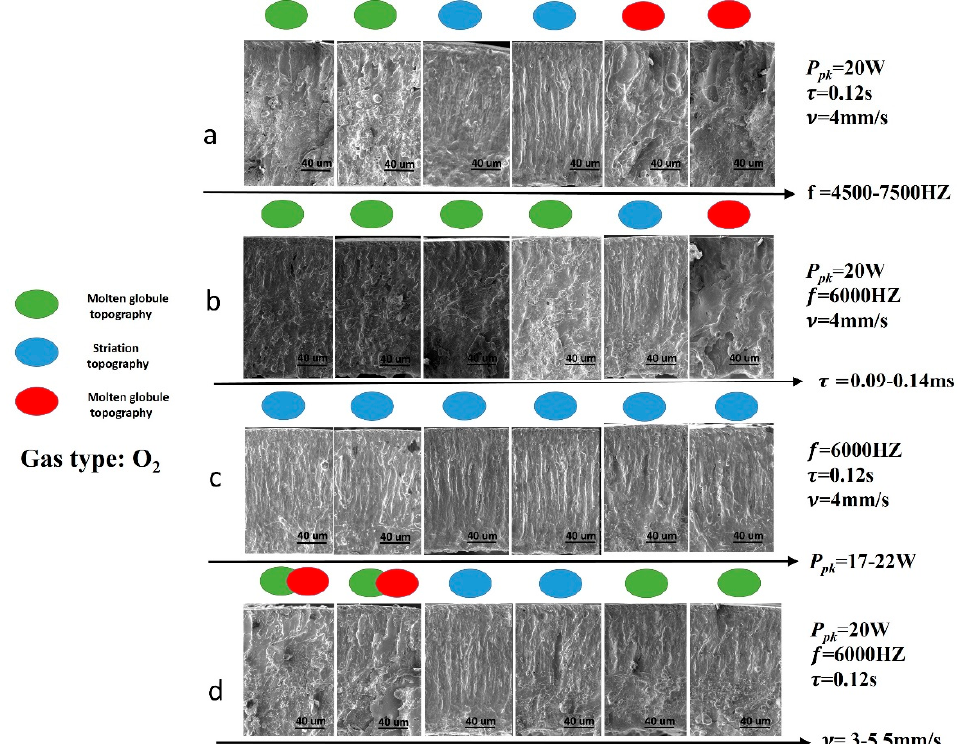
Figure 9. The influences of process parameters on surface topography: ( a ) repetition rate; ( b ) pulse width; ( c ) power; ( d ) cutting speed.